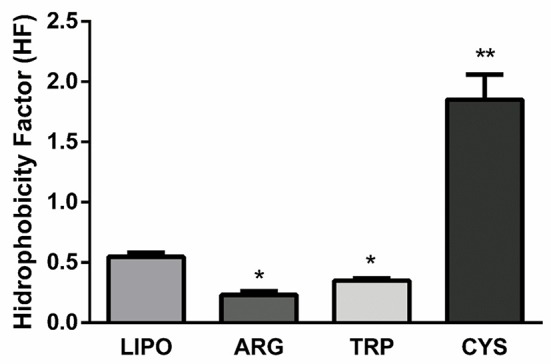
HF (Absorbance at 570 nm/ Absorbance at 500 nm) of the lipopolymer (LIPO) or the lipopolymer with the different amino acids (ARG, TRP, CYS). Data are presented as mean ± SD of four independent experiments. *Significant differences respect to lipopolymer without aminoacids (P < 0.05). **Significant differences with respect to lipopolymer without aminoacids (P < 0.01).